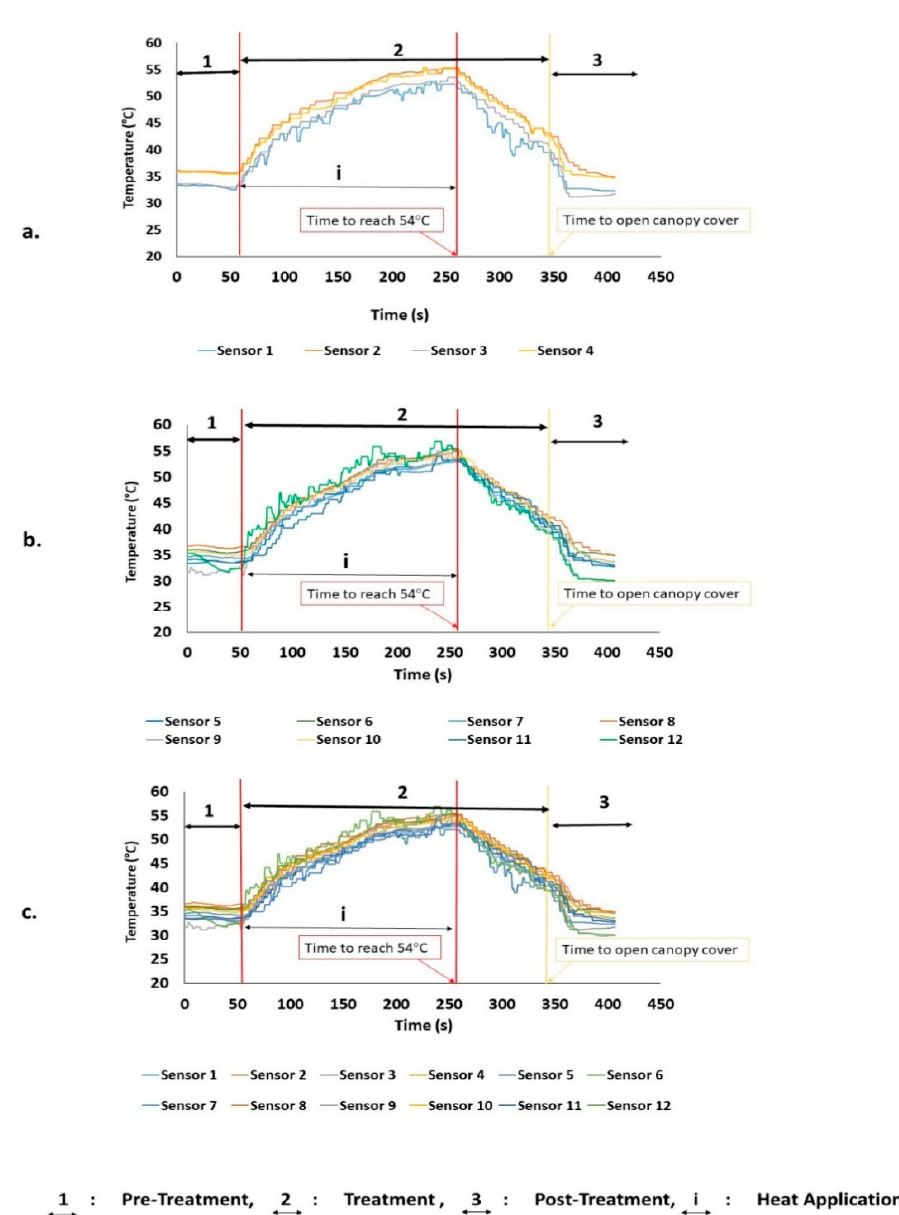
Figure 3. Temperature alterations inside the canopy cover during the steam treatment of Repetition 1.2, a . Zone 1, Trunk (Sensors 1–4); b . Zones 2 and 3, Canopy (Sensors 5–12); and c . Zone 1, 2 and 3, entire tree (Sensors 1–12).